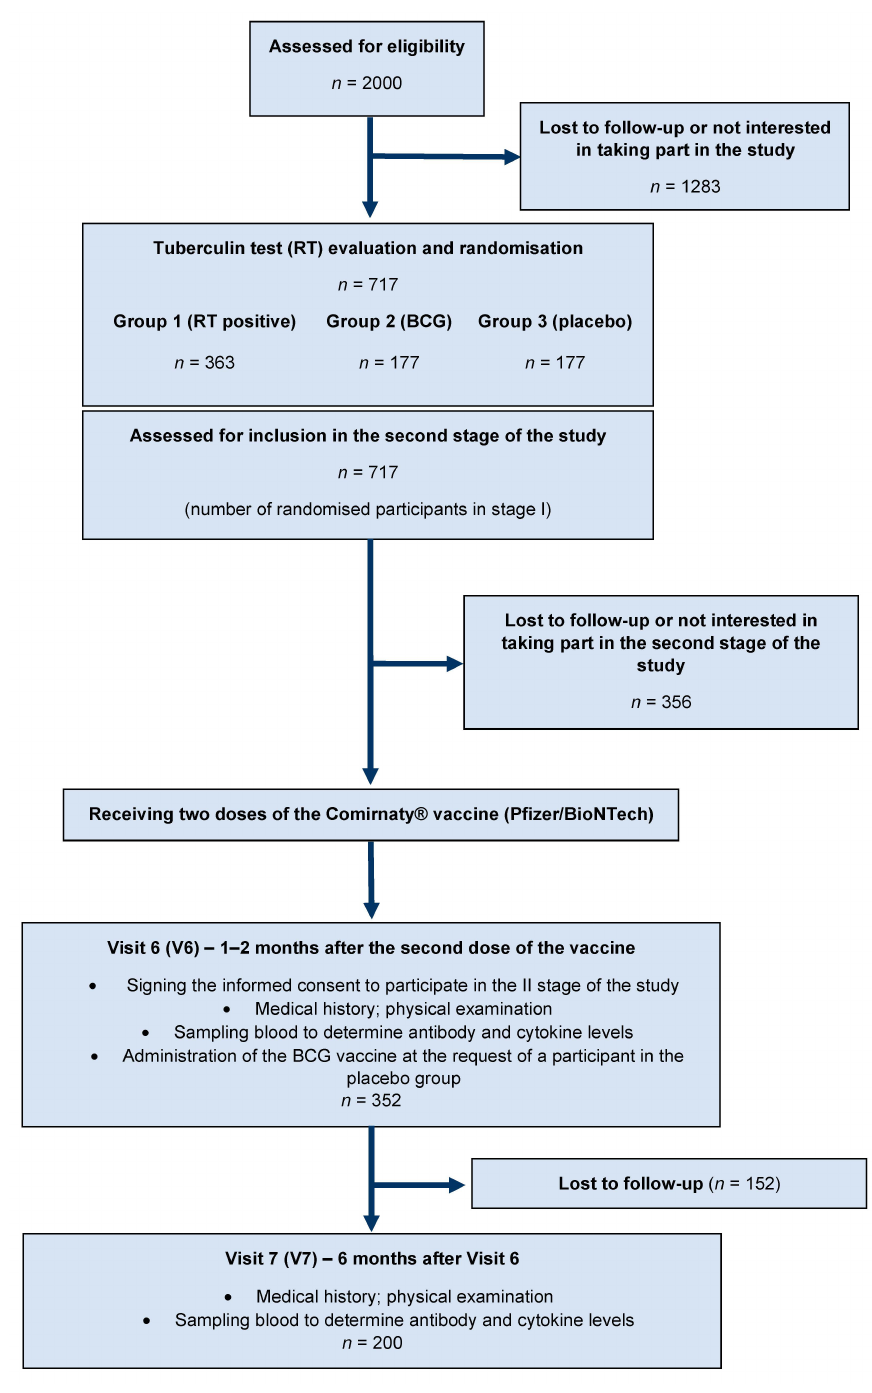
Figure 1. Flow diagram of the